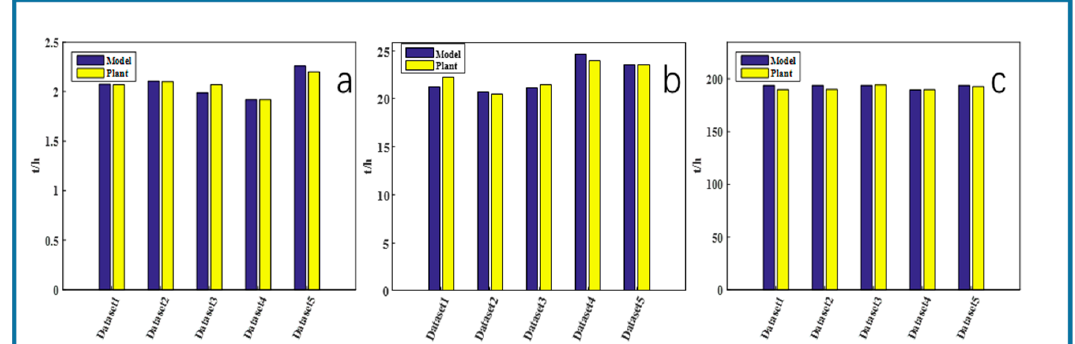
Figure 16. Predictions of the product yield: ( a ) naphtha; ( b ) diesel fuel; ( c ) tail oil.